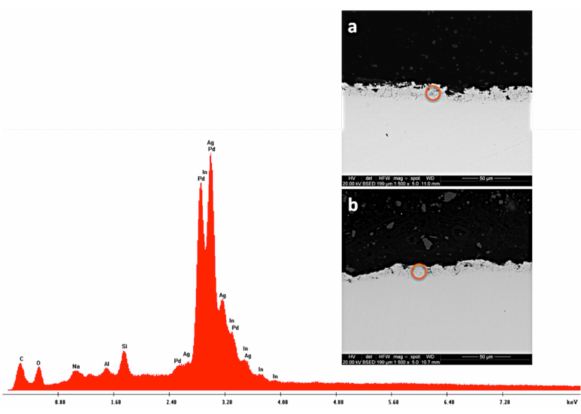
Figure 9: SEM observations and EDS analyses of the oxide layer: (a) drop form alloy, (b) plate form alloy